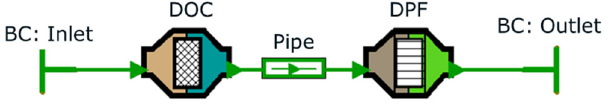
Figure 5. The modeled system of BOOST program.